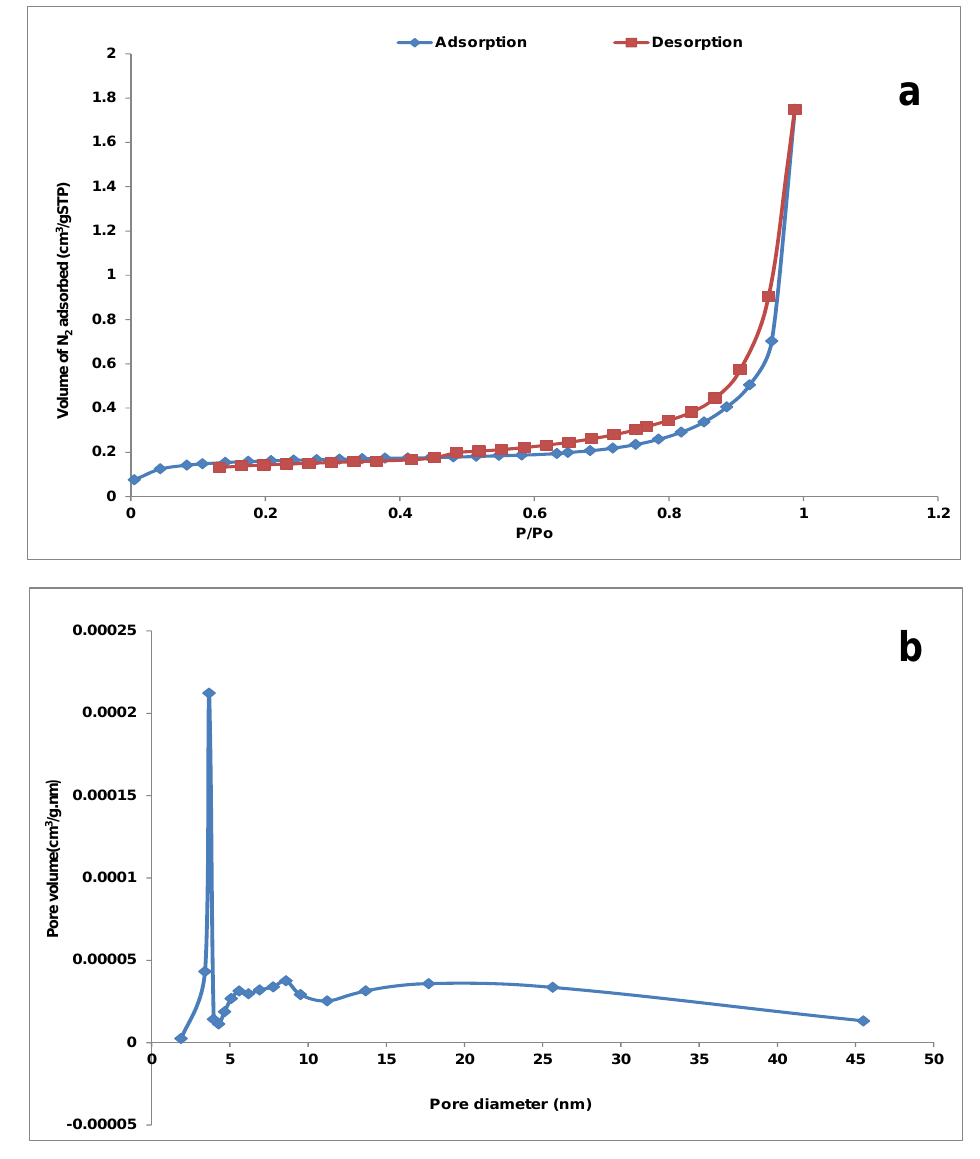
Figure 1. N 2 adsorption ‐ desorption isotherm ( a ) and BJH pore size ( b ) plot of YTBS adsorbent. The classification of nitrogen adsorption ‐ desorption isotherm according to the Brunauer, Deming, Deming, and Teller (BDDT) method [78,79] has been used to characterize the nitrogen isotherm plot of the YTBS adsorbent. From Figure 1a, it can be observed that at low relative pressures (0.1–0.5), the adsorption and desorption branches of the isotherm are nearly horizontal to each other. However, at intermediate to high relative pressures (0.6–0.9), the amount absorbed increases leading to a characteristic type IV isotherm with a hysteresis loop, which is associated with the presence of larger pores in the mesoporous range [80].The presence of this hysteresis has been associated with a number of processes and properties of mesoporous materials. Wickramaratne et al. [81] associates the hysteresis loop in mesoporous materials to the effects of voids created within the adsorbent particles which influence the nature of the nitrogen adsorption and desorption processes. Banerjee et al. [82] and Li et al. [83], on the other hand, attribute this hysteresis loop to the effect of capillary condensation in non ‐ uniform or disordered pore arrangements.